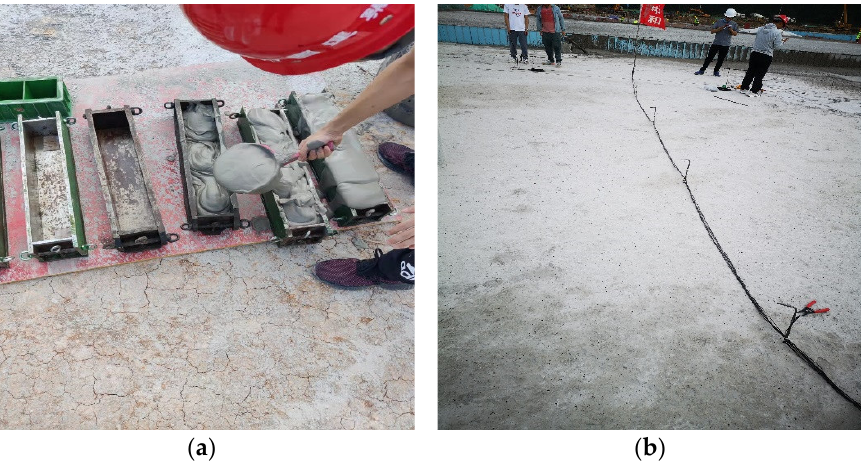
Figure 4. Photos of the construction site: ( a ) on-site sampling tests, and ( b ) FLS surface at the site.